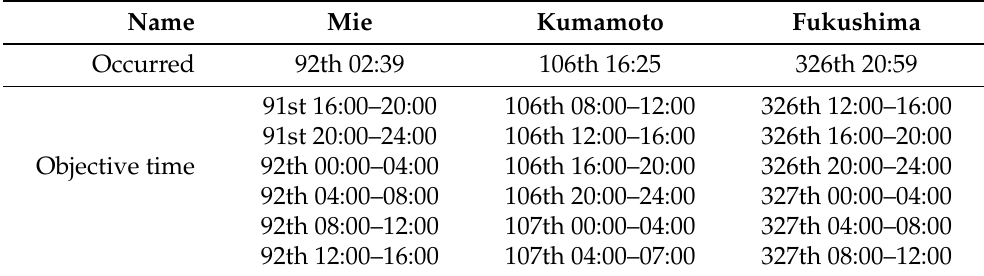
Table 2. Analysis time (the day is written as the day during the year).